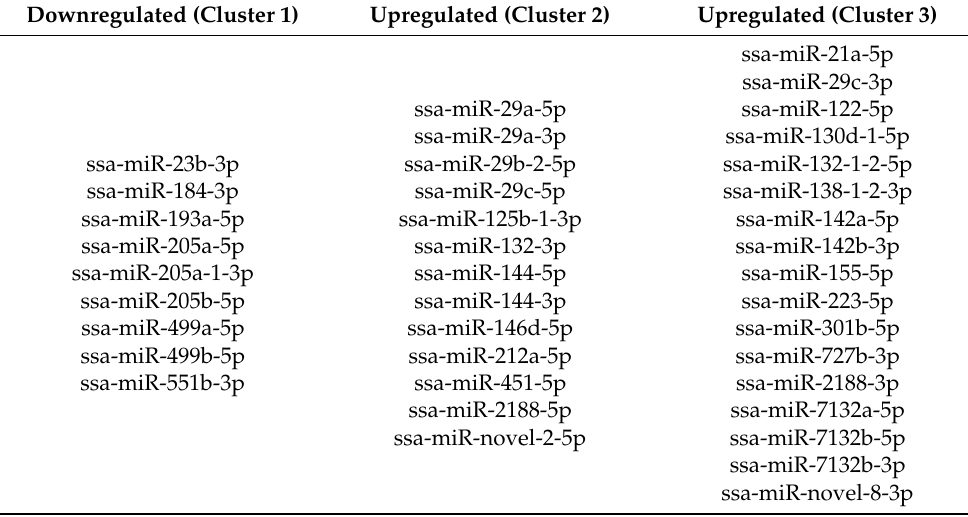
Table 3. Overview of gDE-miRNAs in the CT < 20 group in